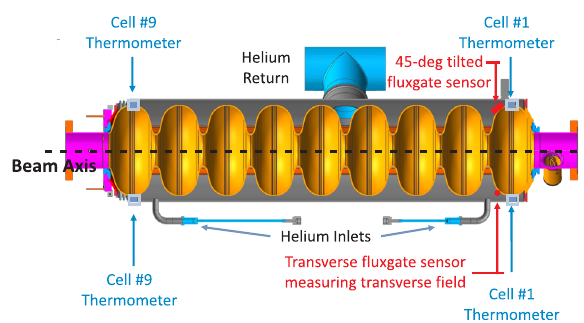
FIG. 1. LCLS-II helium vessel designed to minimize thermo- currents induced by temperature differences between the two ends of the nine-cell cavities, with symmetric helium inlets and central connection to the helium return line. For the prototype cryomodule, temperature sensors and fluxgate magnetometers were installed on four of the eight